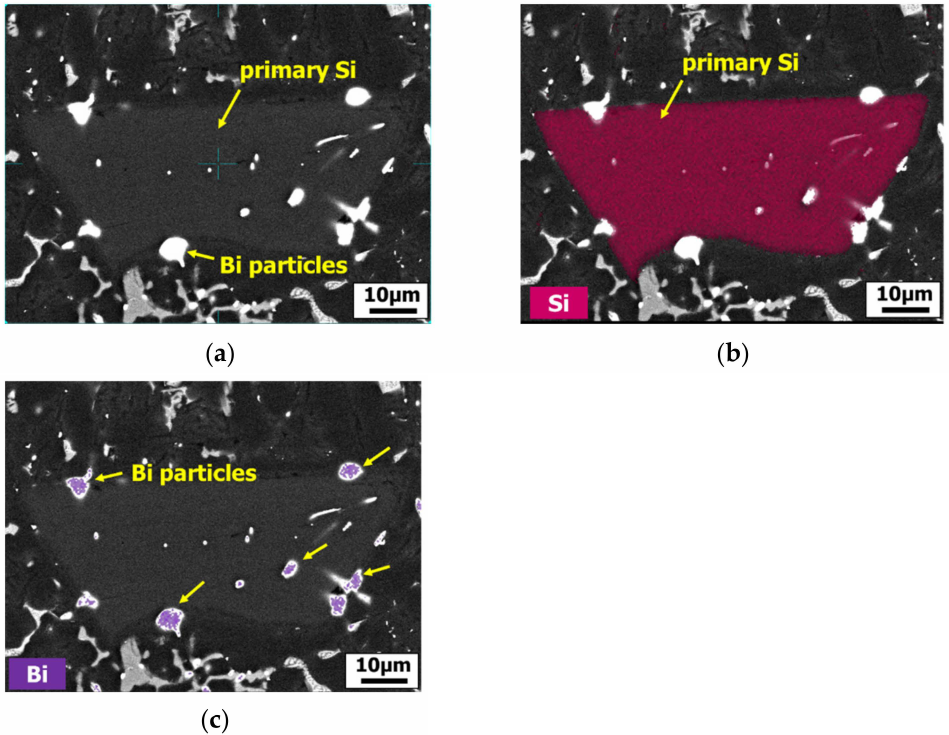
Figure 11. Elemental mapping shows on B390-1Bi ( a ) Bi particles are inside and at the surface of primary Si ( b ) elemental mapping of Si, and ( c ) elemental mapping of